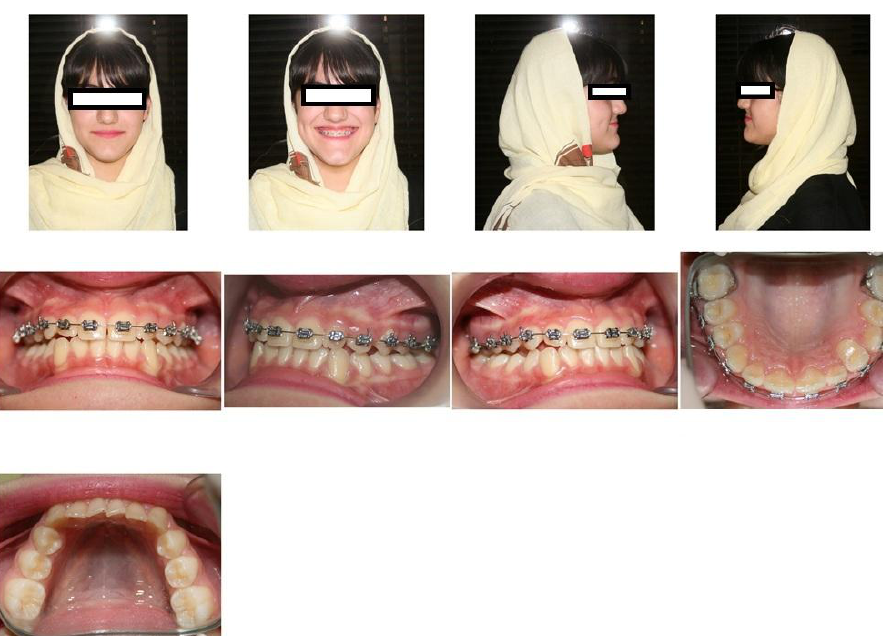
Figure 9. Intra-oral and extra - oral views of the upper and lower dental arch showing successful canine-premolar